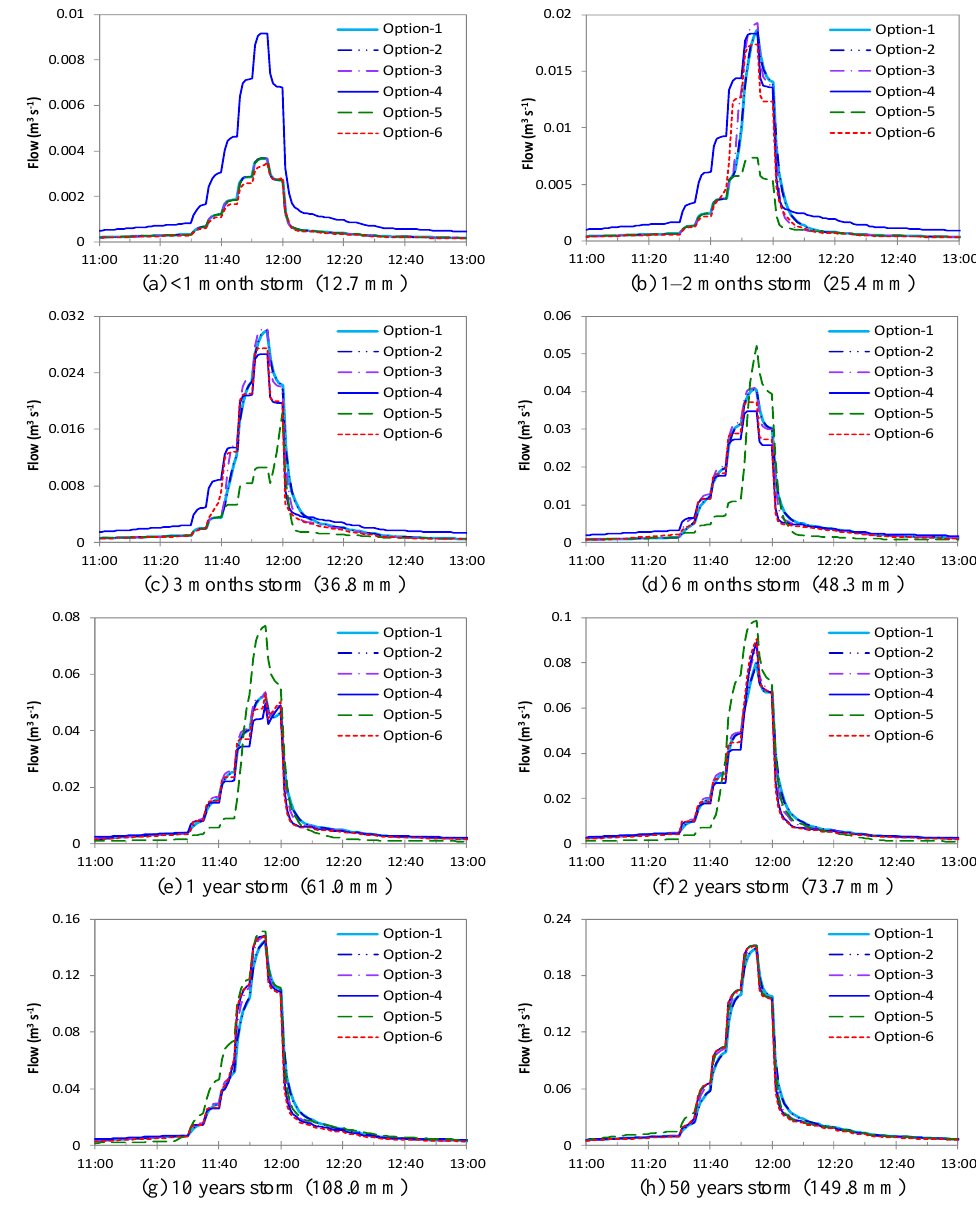
Figure 8. Hypothetical HRE SWMM modeling